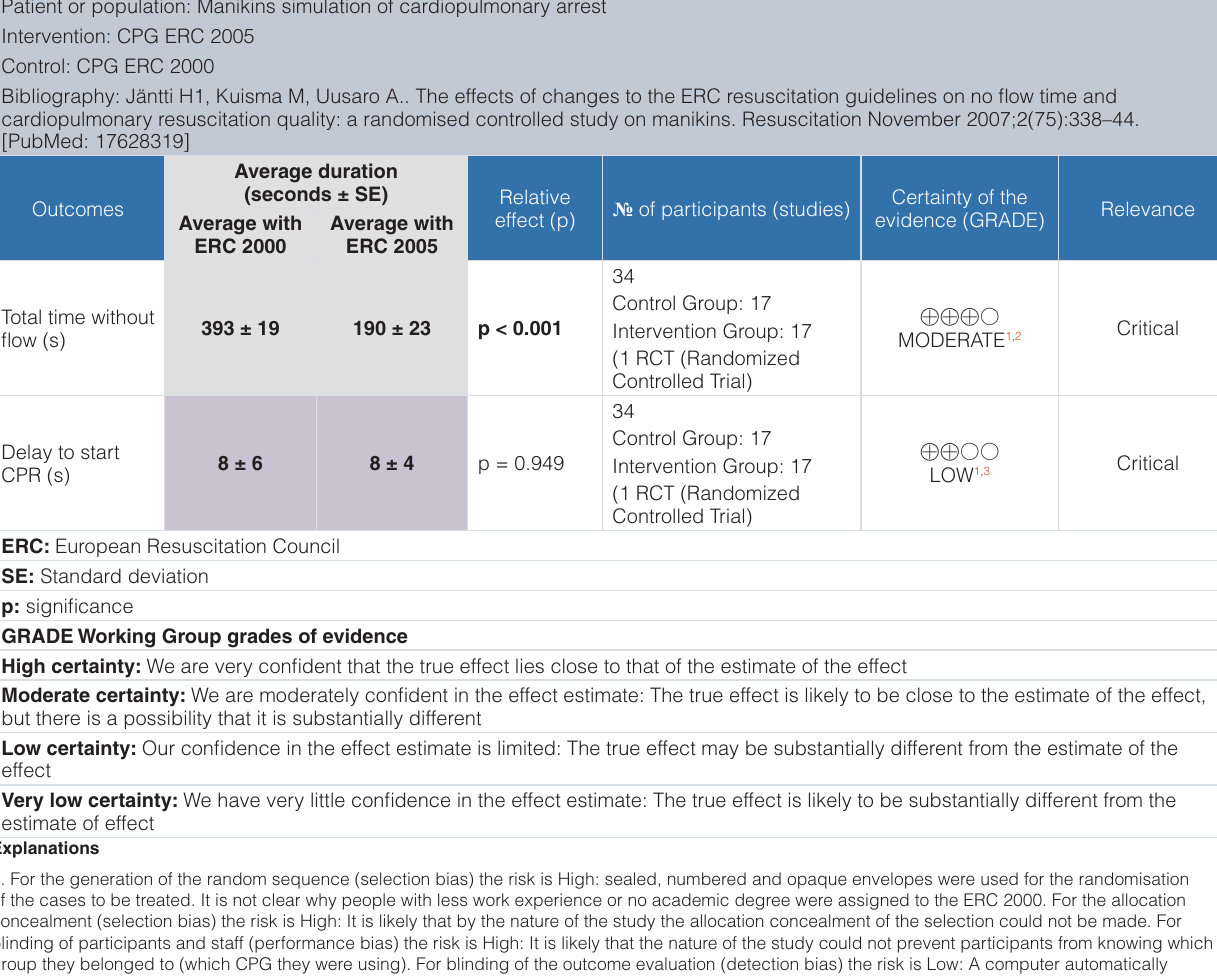
Table 1. Evaluation of the Certainty of the Evidence for the Jäntti 2007 study on cardiopulmonary resuscitation, according to the GRADE classification. Are the recommendations presented in the ERC 2005 CPG better than those presented in the ERC 2000 CPG more adequate to improve the outcomes for cardiopulmonary resuscitation? Patient or population: Manikins simulation of cardiopulmonary